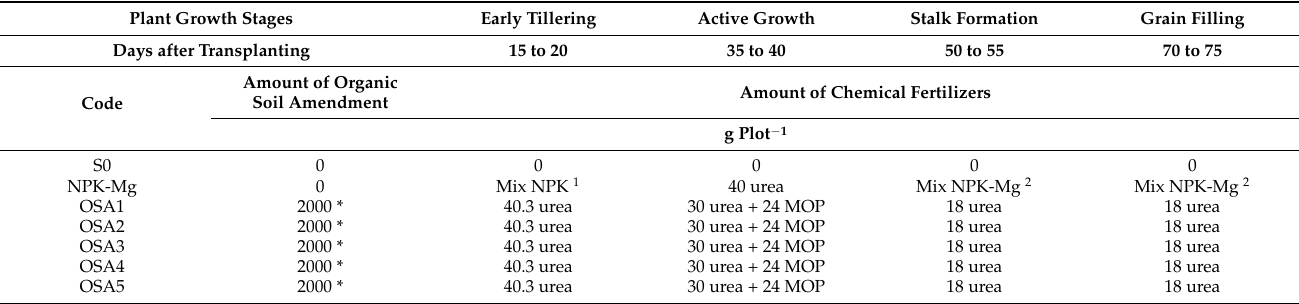
Table 3. Application rates of organic soil amendments and fertilizers used in the field study. Plant Growth